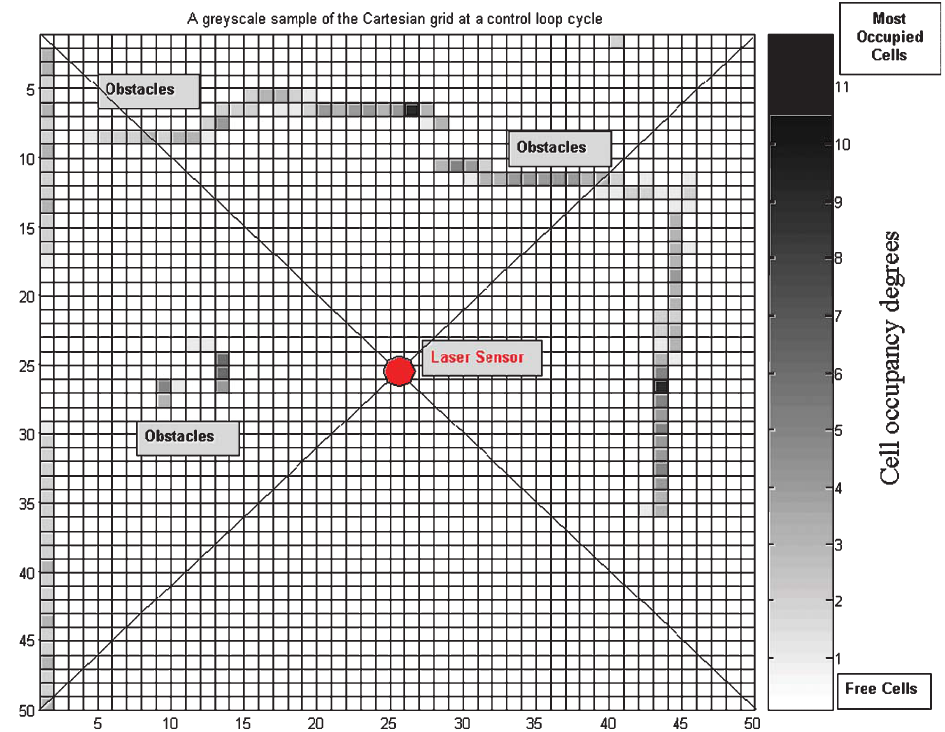
Fig. 3. Cartesian grid filled up with certainty values, displayed using greyscale.